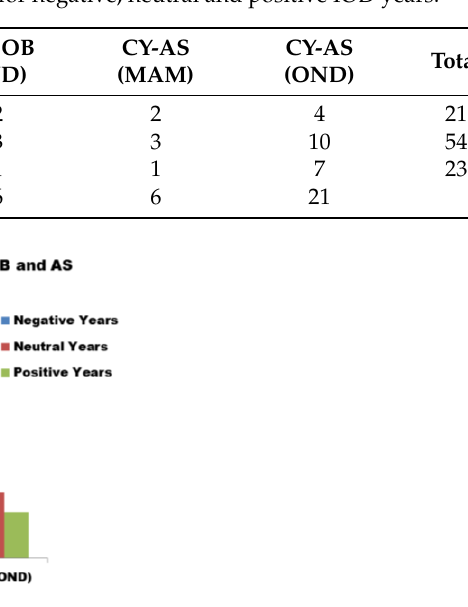
Figure 9. Frequencies of pre − monsoon and post − monsoon tropical storms during IOD years (1971– 2020) in BOB and AS.